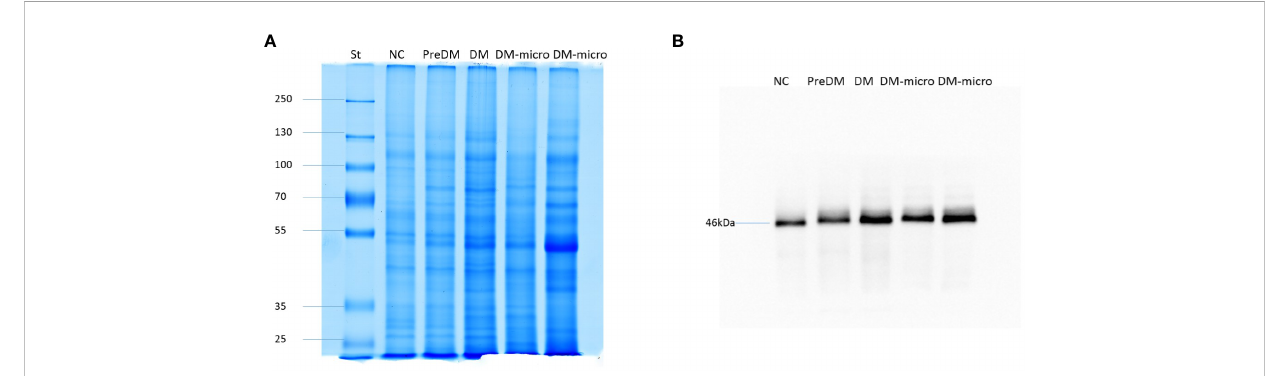
FIGURE 5 Protein pattern of uEVs and western blot of TSG101. (A) . Protein pattern of uEVs on the colloidal gel. (B) . Western blot of TSG101 as biogenesis biomarker of uEVs.